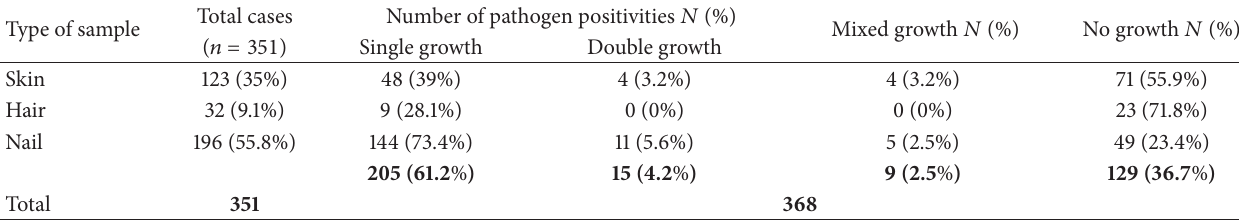
Table 3: Total number of cases and culture